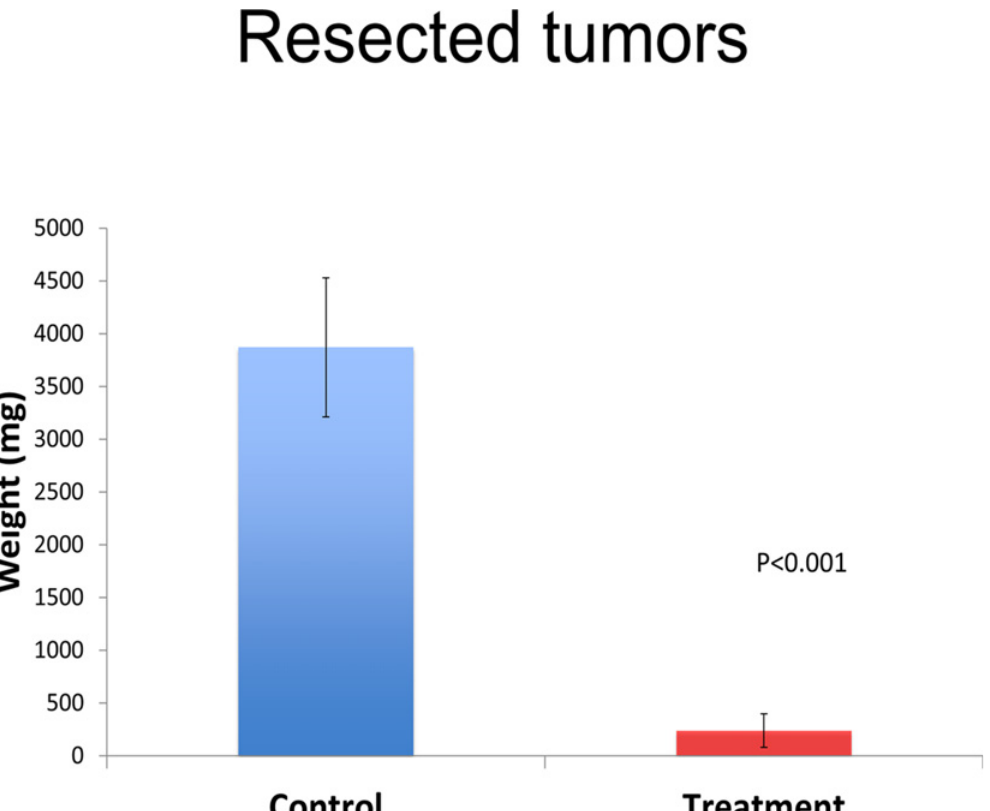
Fig 6. Graphical representation of tumor weights. A significant difference was noted with average tumor weights after tumor resection. A significant difference in tumor weight was noted between the treatment and control groups (p <